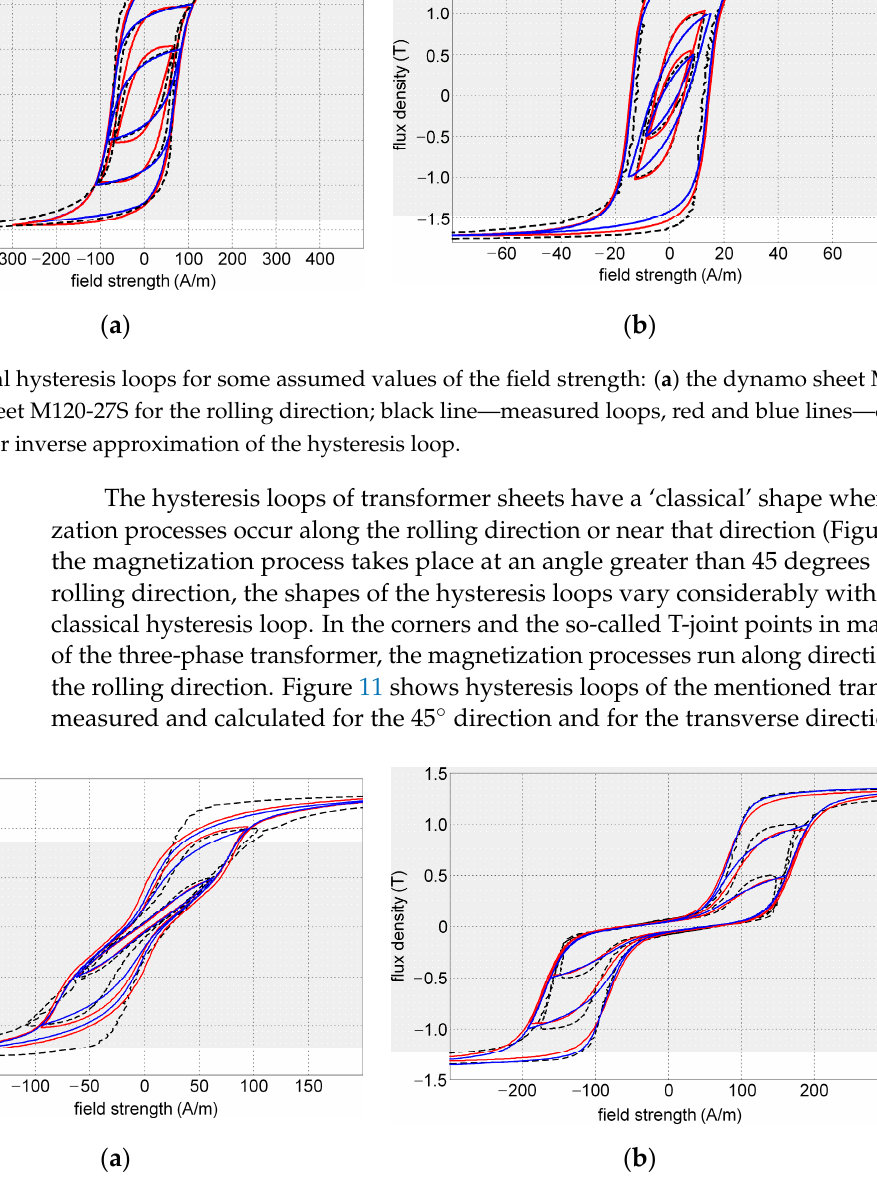
Figure 11. Hysteresis loops of transformer sheet M120-27S: ( a ) for the 45° direction; ( b ) for the transverse direction; line markings as in Figure 10.